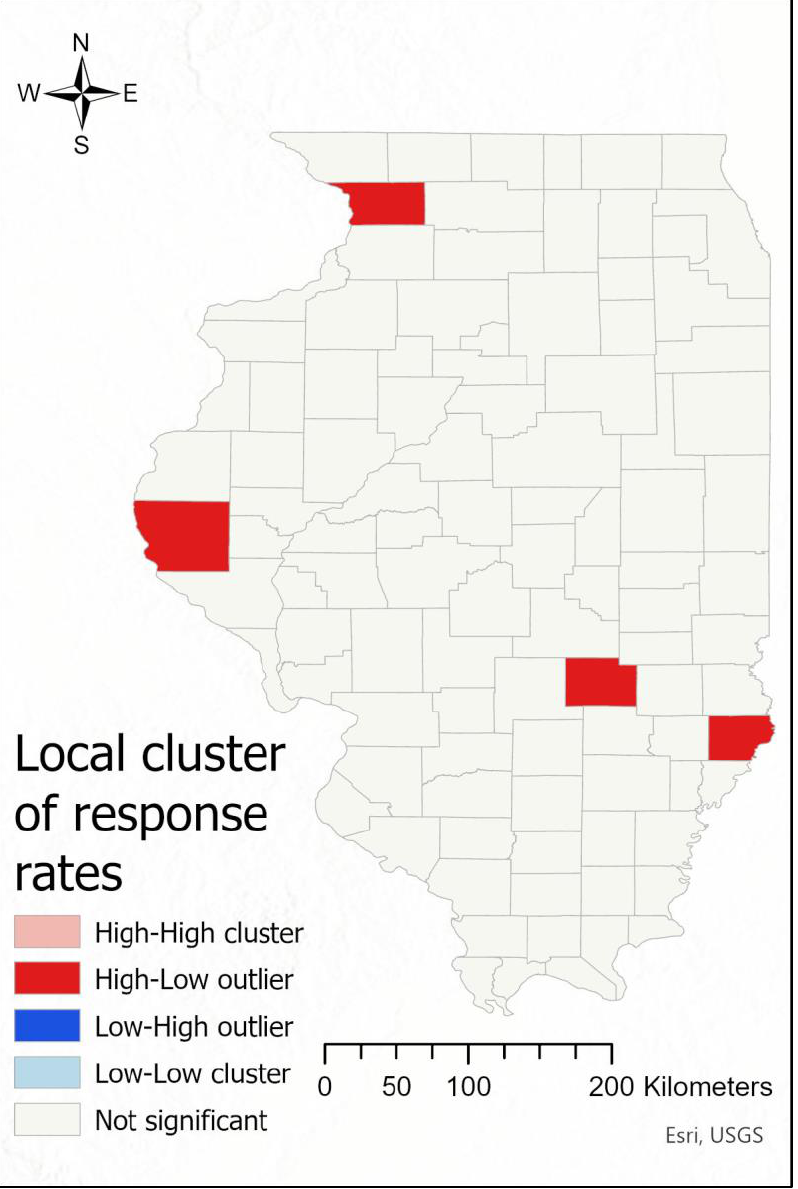
Figure 3. Cluster and outlier analysis (local Moran’s I) results of the survey response rates.